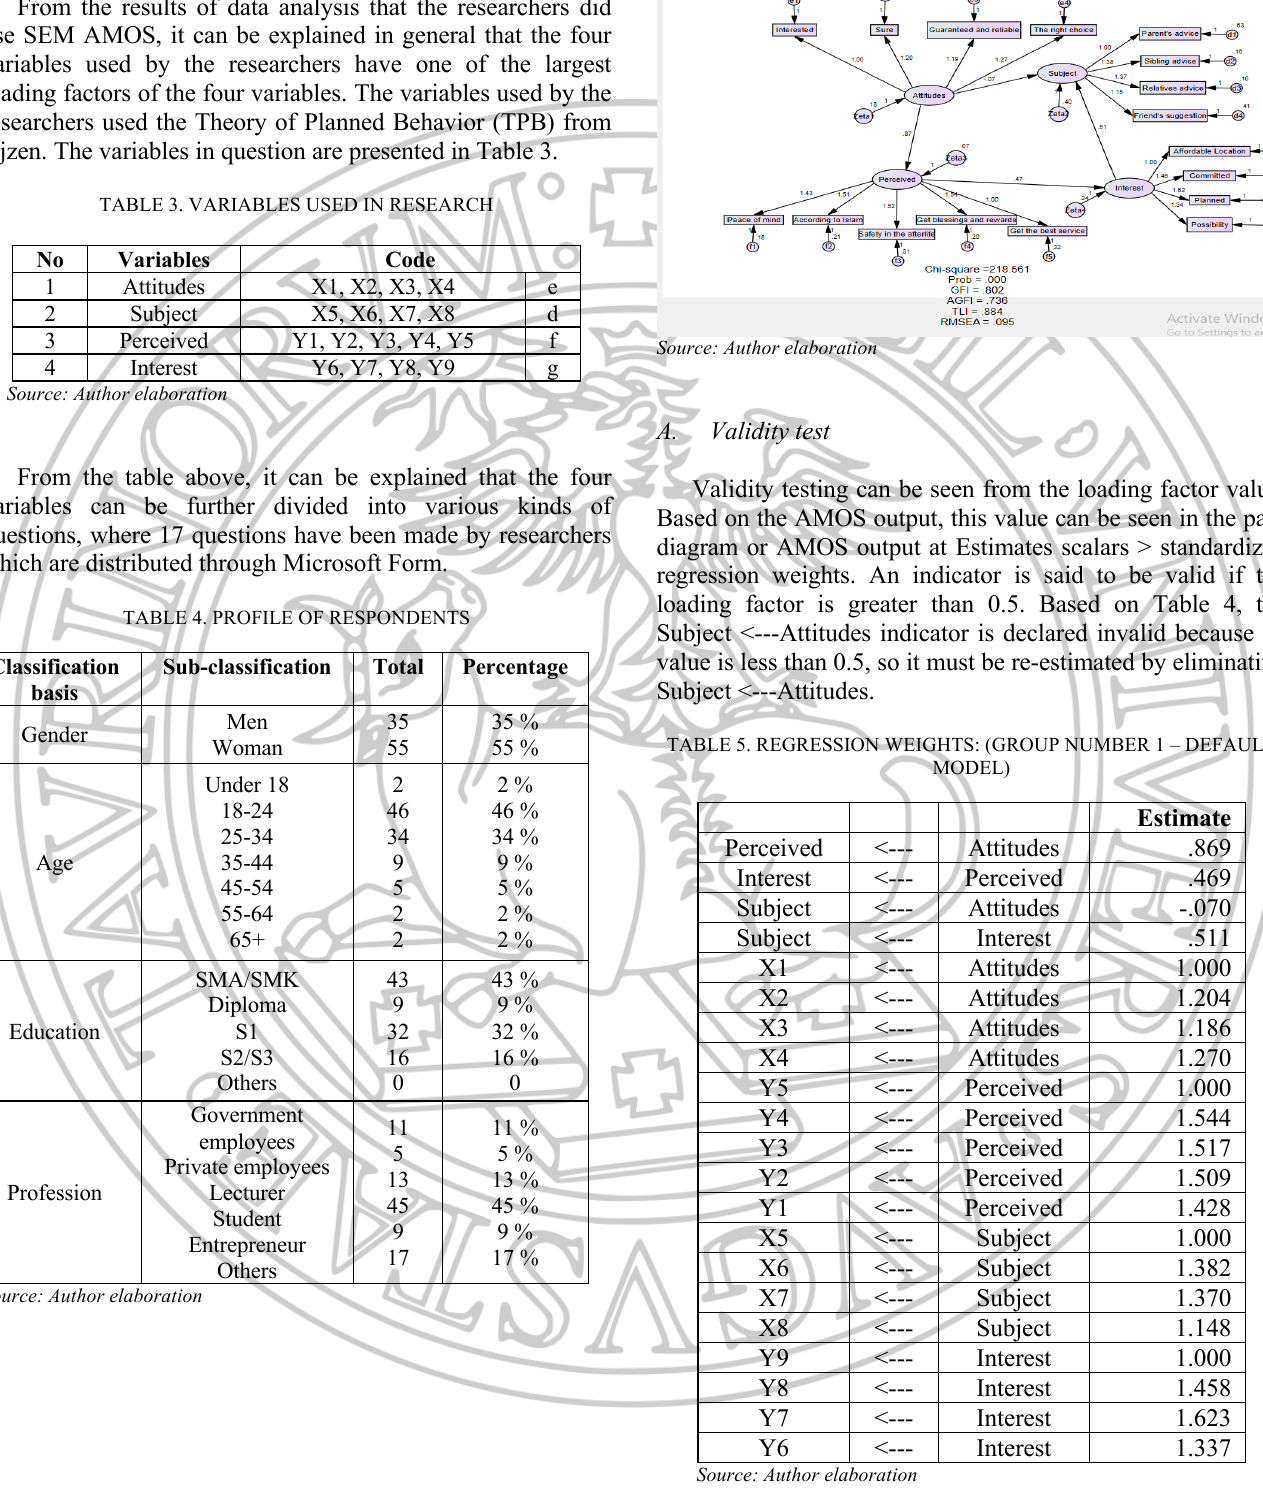
FIGURE 1. CONVERGENT VALIDITY TESTING